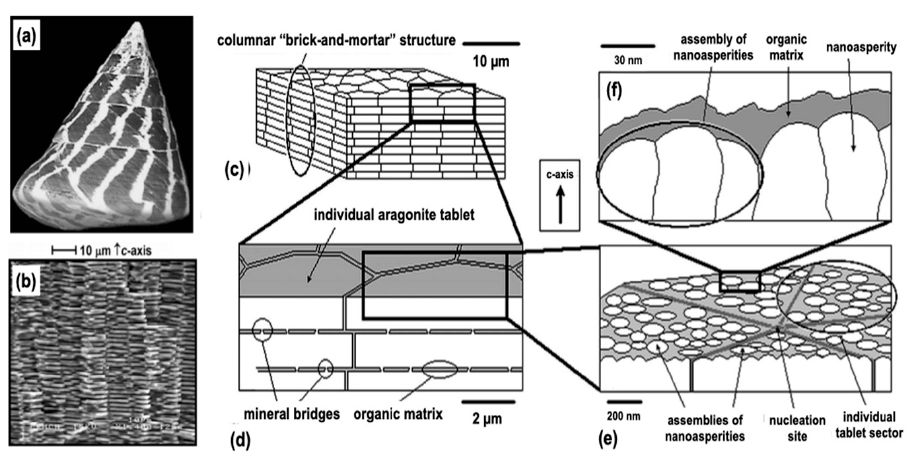
the world, has a densely stacked structure of polygonal aragonite (CaCO 3 ) (width ~8 mm; thickness ~0.9 mm; stacking interval ~40 nm) [11].